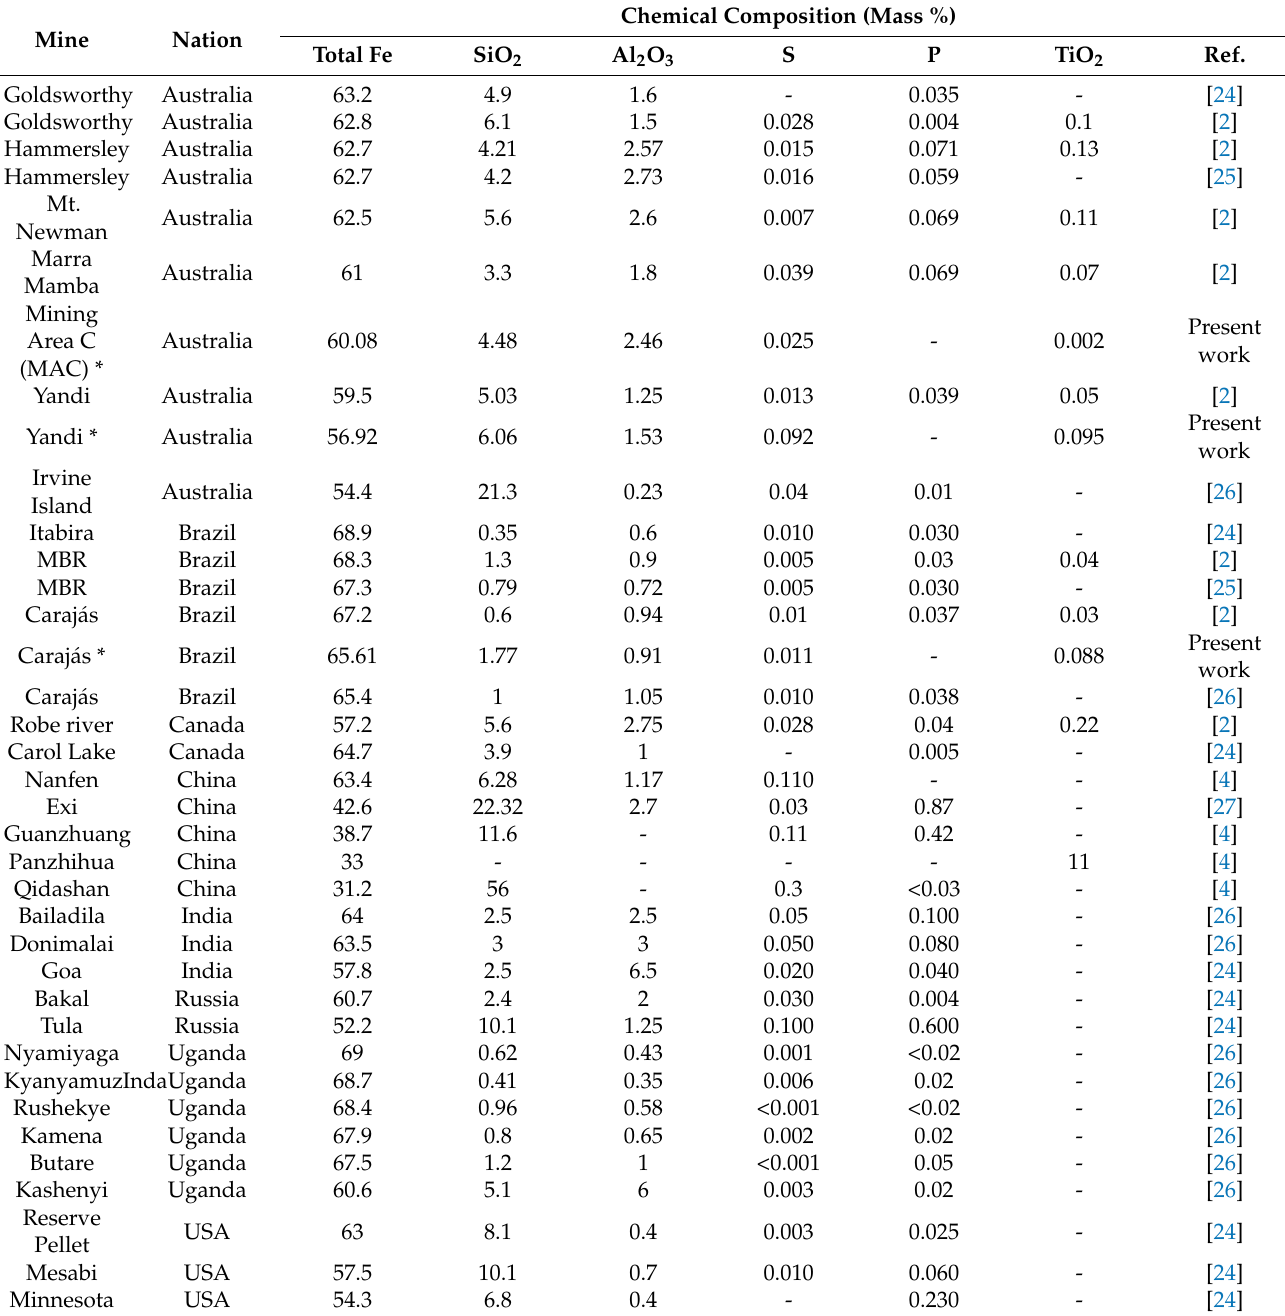
Table 2. Chemical composition of iron ores in different